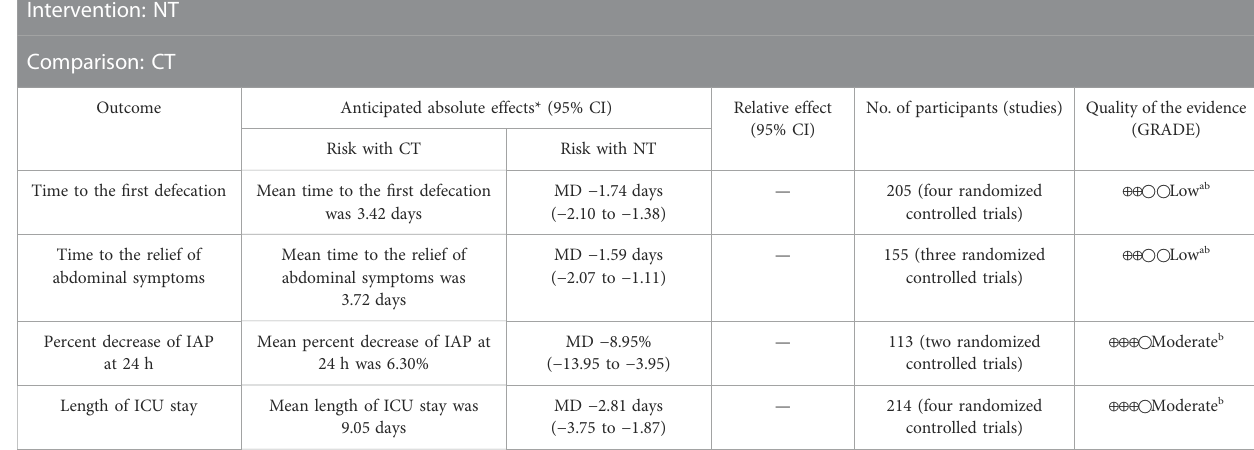
TABLE 2 Summary of the main fi ndings. Population: Patients with non-mild